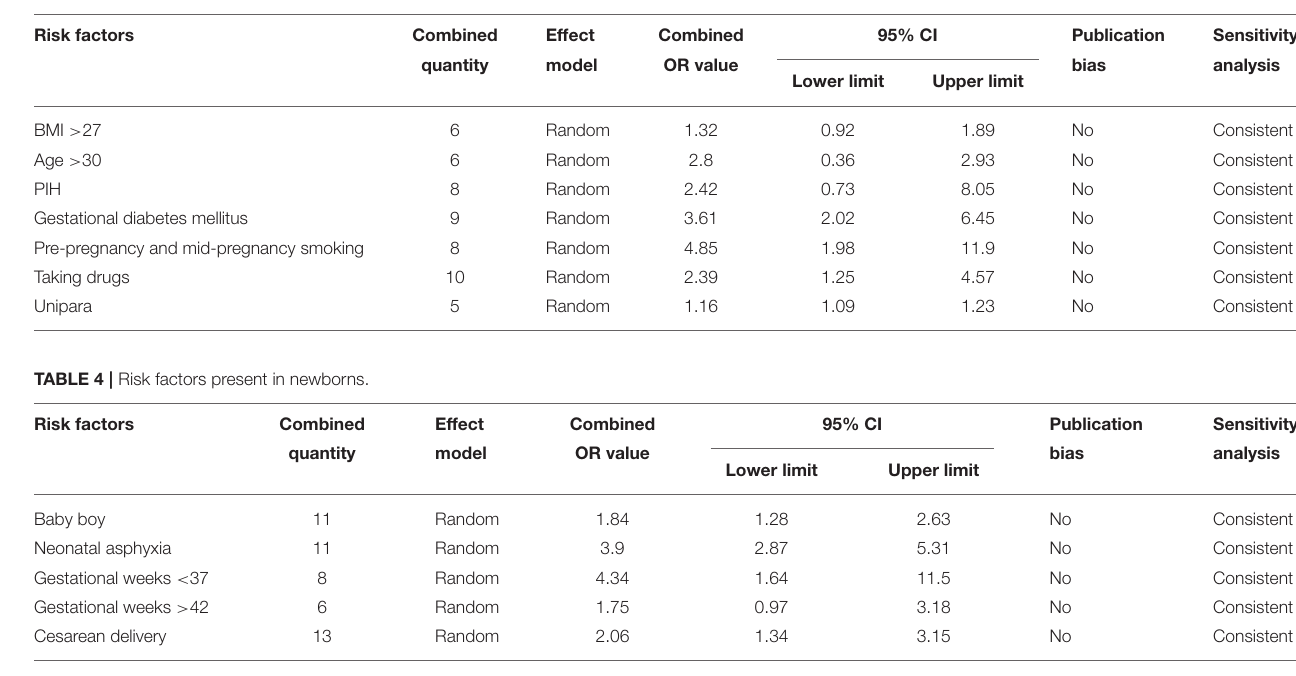
TABLE 3 | Risk factors present in pregnant women.